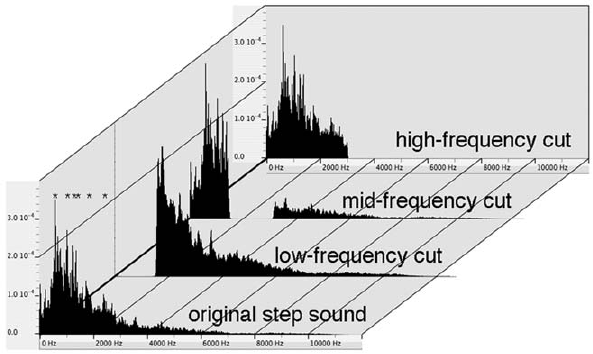
Figure 2. Power spectra of the footstep sound and its spectrally modified versions with different frequency bands removed. Power (relative) is on the y-axis, and spectrum (Hz) is on the x-axis. Overall power levels of the spectrally modified sounds are adjusted to be equal to that of the original target sound.